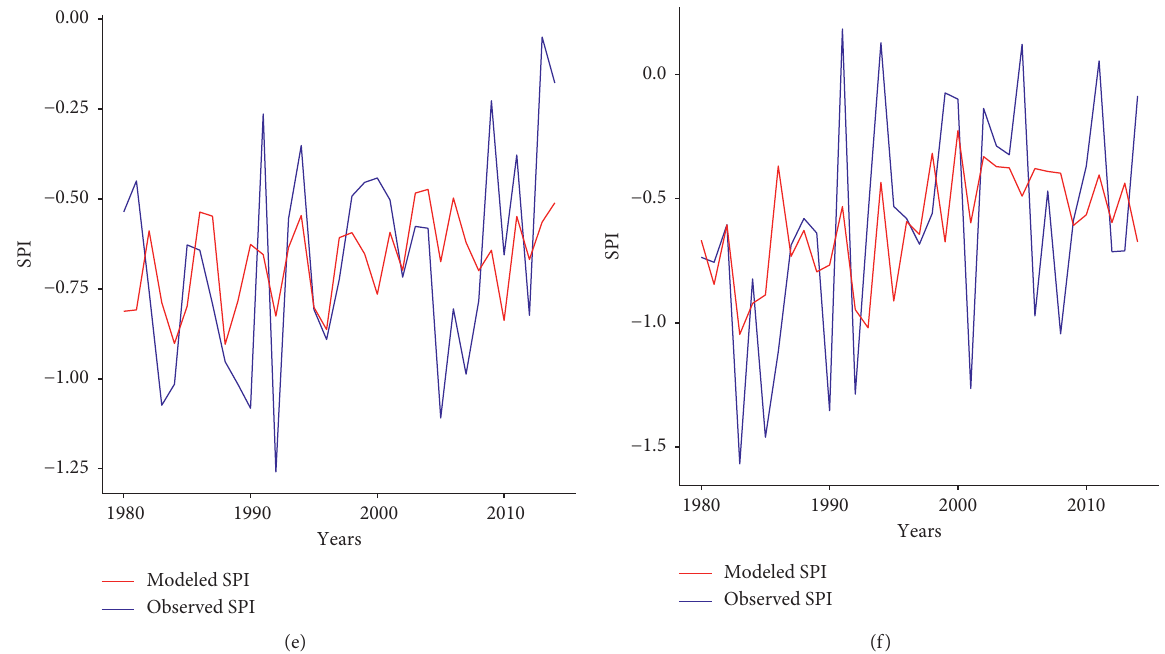
Figure 5: Comparison of modeled NDJ SPI based on OND climate indices versus observed NDJ SPI for (a) Accra, (b) Ada, (c) Tema, (d) Saltpond, (e) Takoradi, and (f) Axim meteorological stations at timescale of drought periods. The observed SPI is in blue and red is